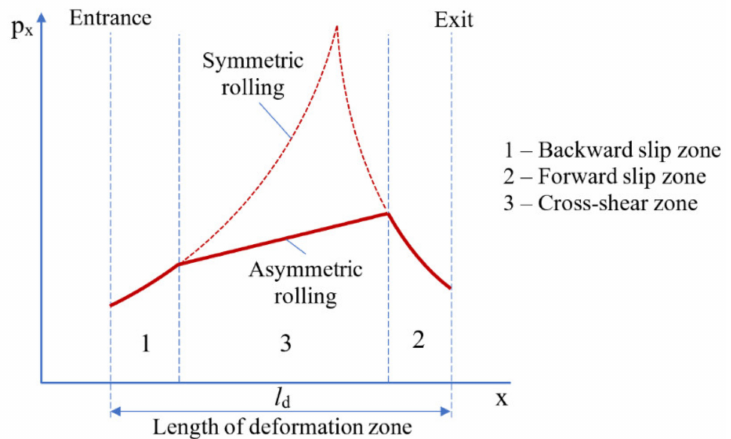
Figure 17. Schematic illustration of pressure distribution along the deformation zone during sym- metric and asymmetric rolling.